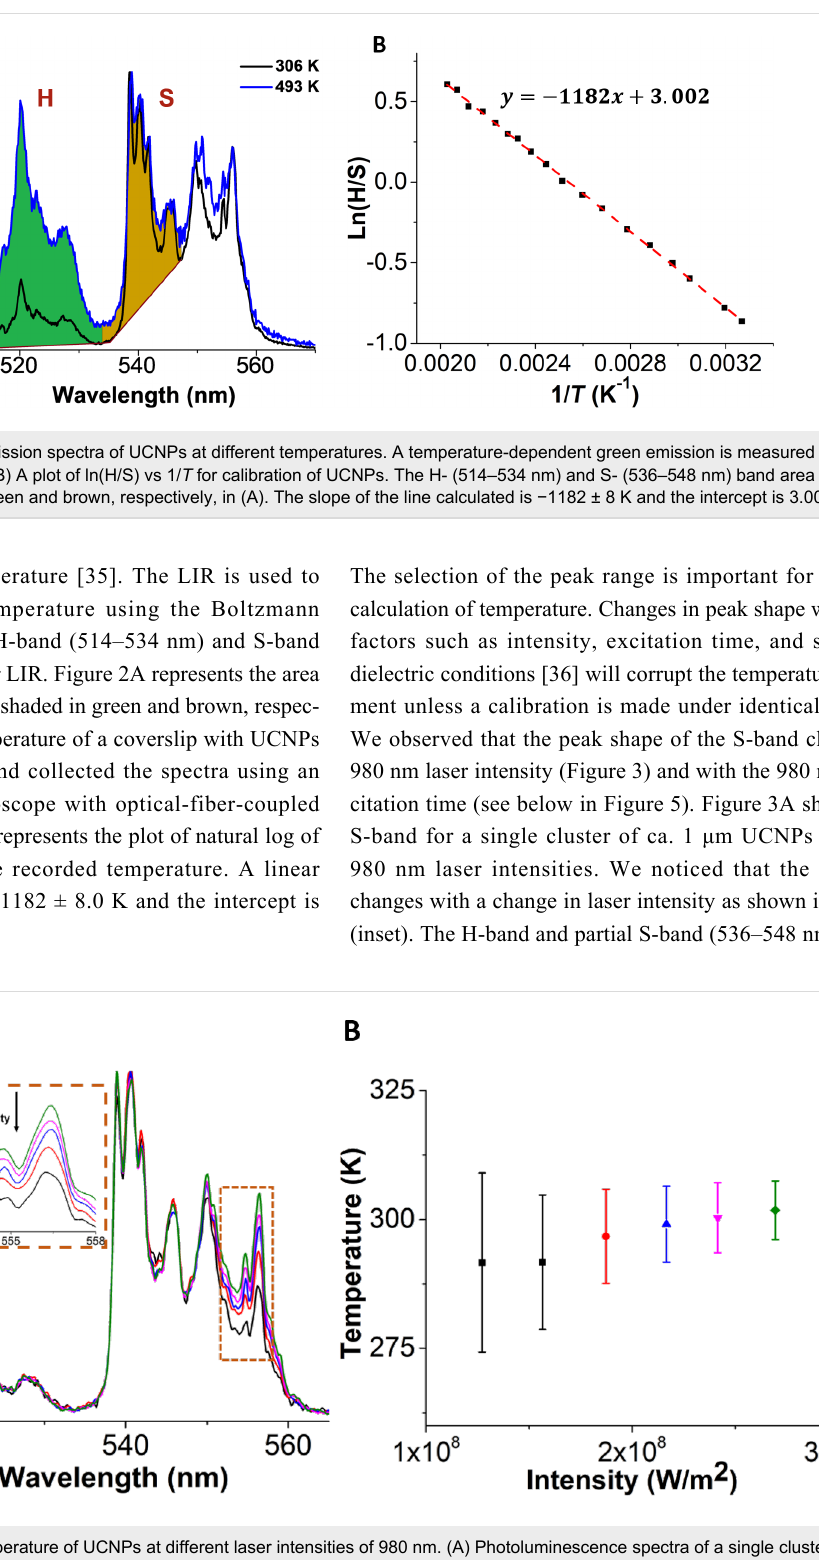
Figure 3: Measurement of temperature of UCNPs at different laser intensities of 980 nm. (A) Photoluminescence spectra of a single cluster of UCNPs of ca. 1 μ m size at different laser intensities. With the decrease in intensity, there is also decrease in an integrated area of S-band after 548 nm. The inset shows an enlarged view of a change in peak intensity with respect to laser intensity. (B) A plot of an average temperature plotted as a function of 980 nm laser intensity. The temperature calculated remains constant with a decrease in standard deviation upon an increase in laser intensity. An emission spectrum of a given color in (A) represents a temperature in the plot in (B).